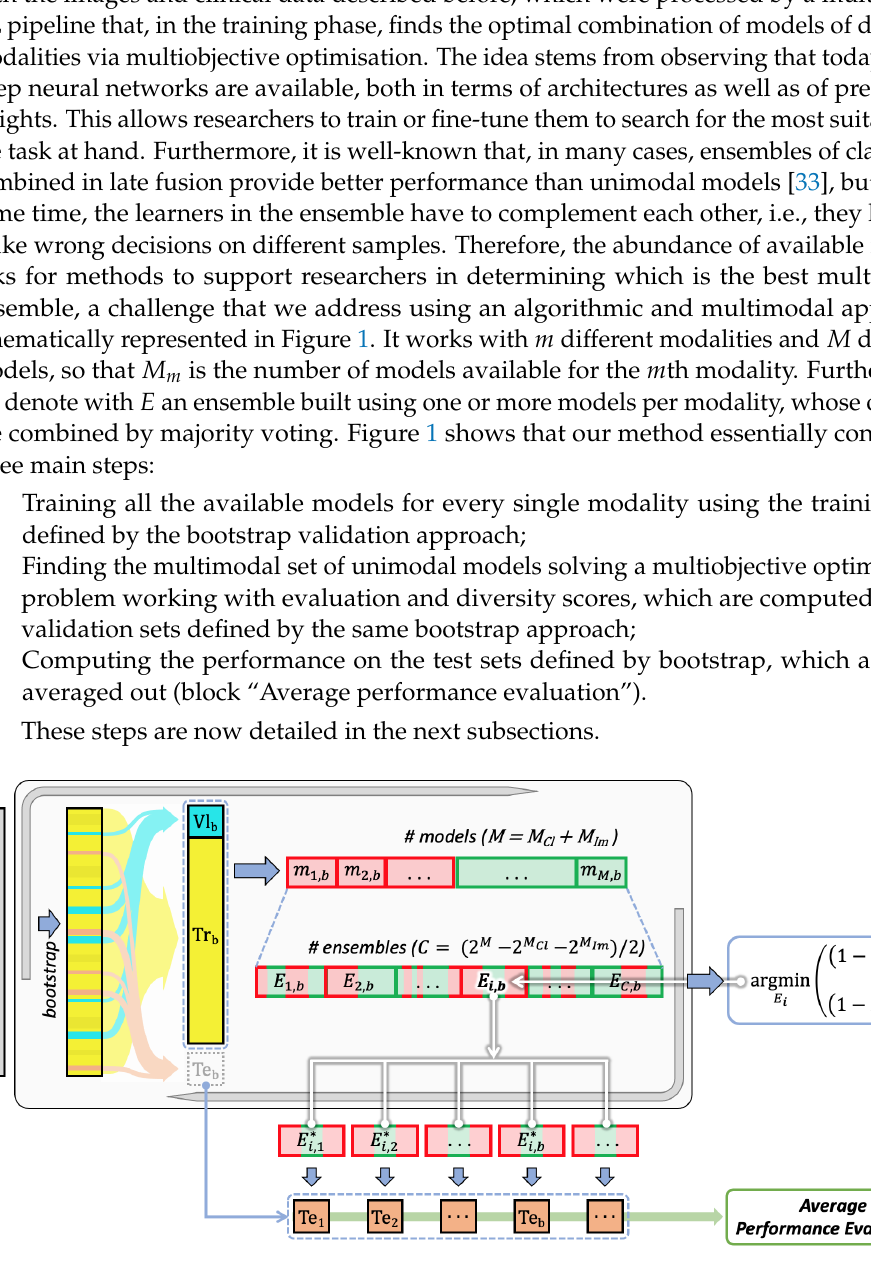
Figure 1. Schematic view of the pipeline. Symbols: Tr : training set, Vl : validation set, Te : test set, m : model, M : number of models ( · Cl : for clinical data and · Im : for data from images), · b : a generic bootstrap fold, E : (models’) ensemble, · i : a generic ensemble, C : number of ensembles, R : function of recall, K : function of